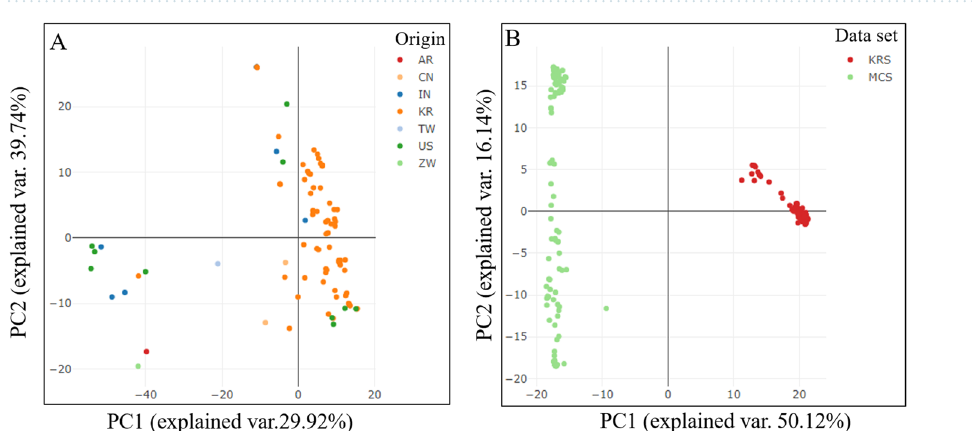
Figure 6. Principal component analysis (PCA) of Korean set and Merge set of peanut genotypes. ( A ) Korean set was classified according to the origin of genotypes (AR- Argentina, CN- China, IN- India, KR- Korea, TW-Taiwan, US- United State of America, and ZW-Zimbabwe). ( B ) Merge set classified according to the data set (KRS- Korean set of genotypes and MCS- Merged set of